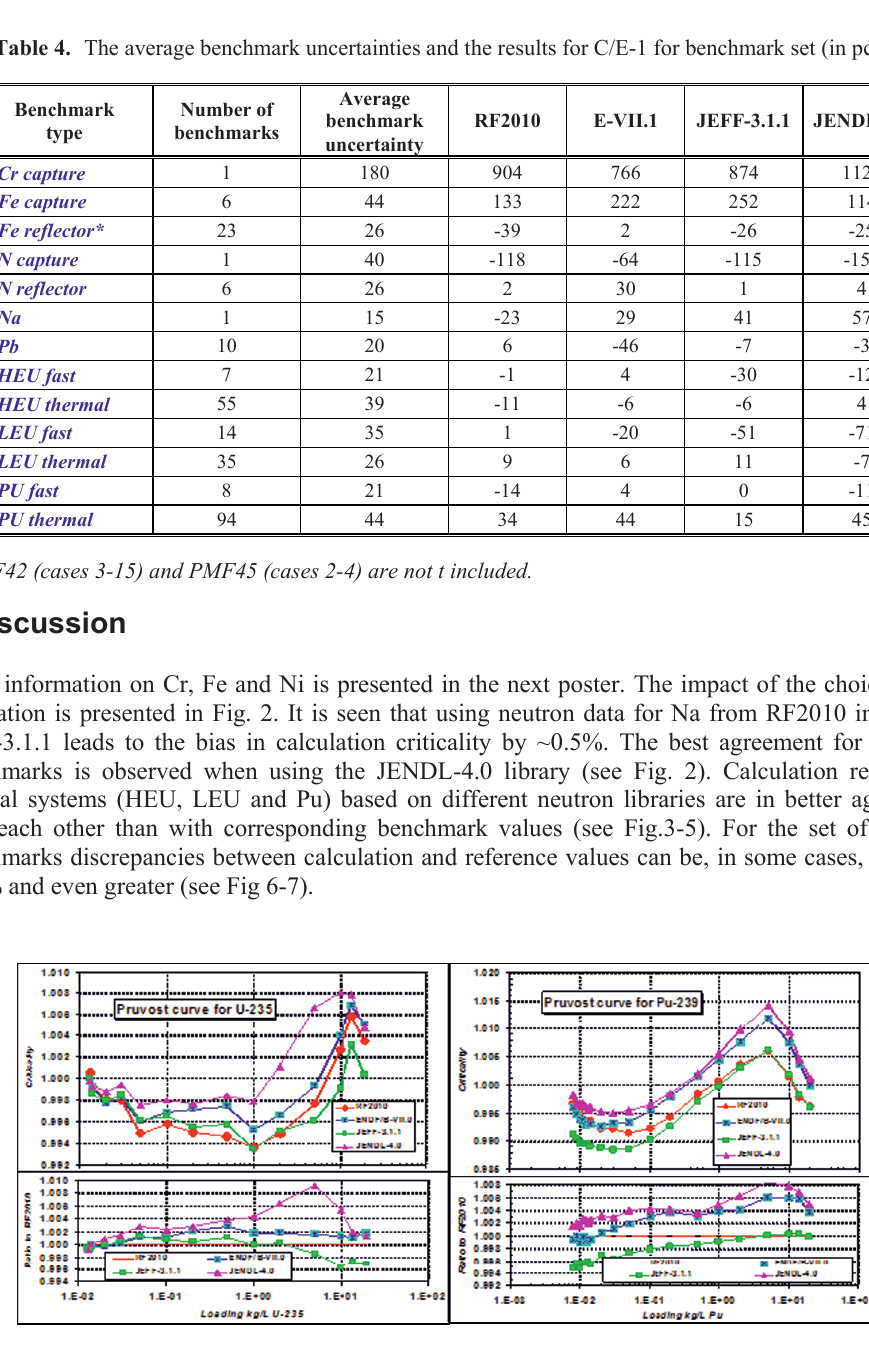
Fig. 1: Pruvost curves for U-235 and